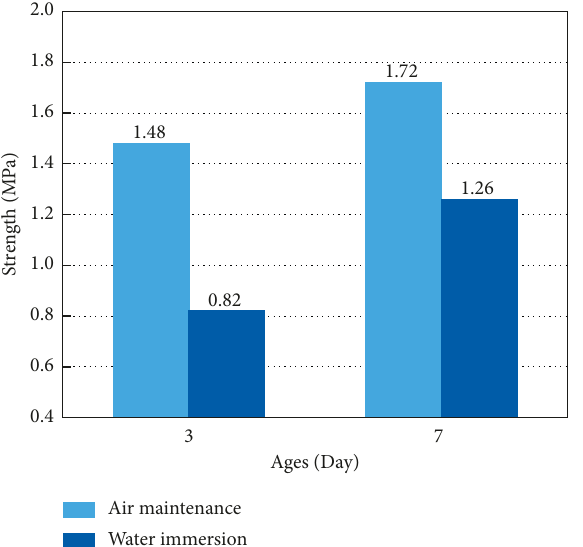
Figure 12: Changes in strength of MOC solidified soil after water immersion. Figure 13: Infiltration conductivity of MOC solidified soil with different